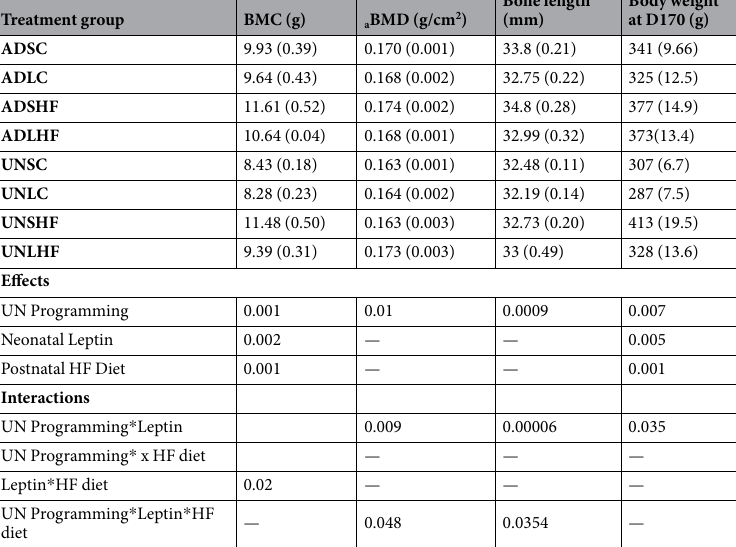
— Table 1. Group mean ( ± SEM, n = 8 per group) whole body bone mineral content (BMC) and areal bone mineral density ( a BMD) measured by dual energy x-ray absorptiometry (DXA), femur bone length, and body weight at D170 of 8 groups of female rats exposed to combinations of programming (UN = undernutrition vs AD = ad lib feeding during pregnancy), leptin (L) vs saline (S) administration on neonatal days 3–13, and high fat (HF) vs chow (C) diet